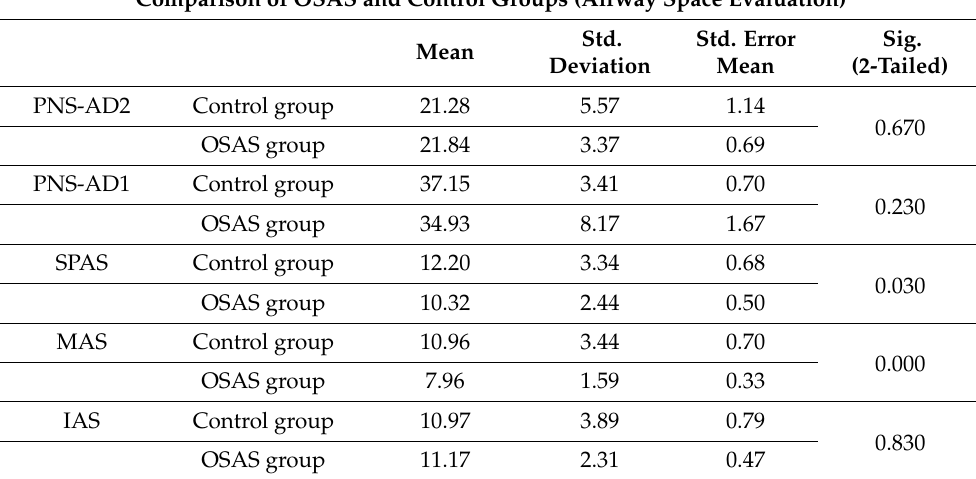
Table 4. The comparison of the airway evaluations between the OSAS group and control group. Comparison of OSAS and Control Groups (Airway Space Evaluation)